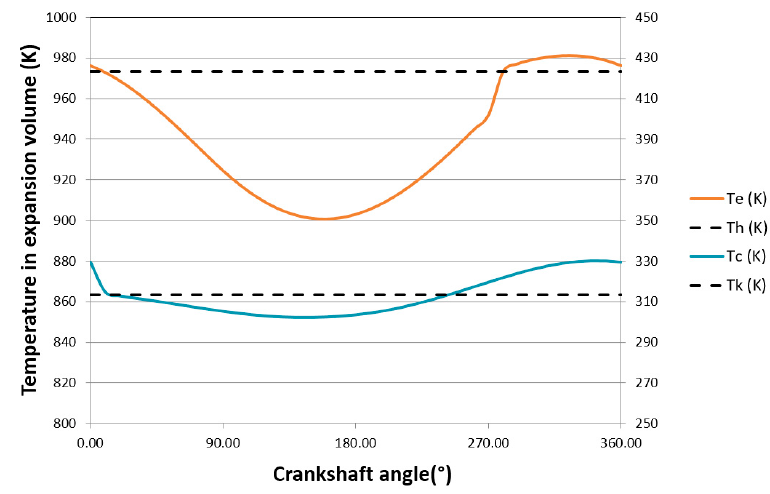
Figure 5. The temperatures during compression and expansion.